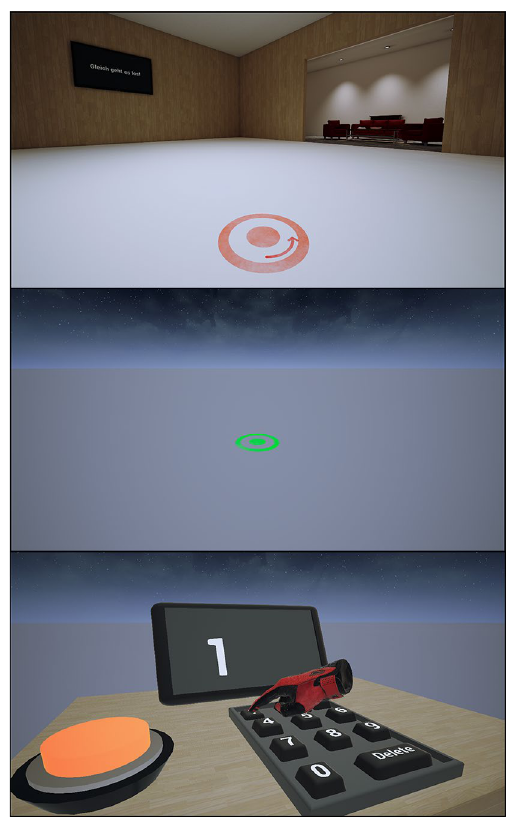
Figure 1. Screenshots of the virtual room environment (upper panel) and the ground plane environment (middle panel) that were custom created in Unreal Engine 4.25 for this research project and used in the experiments. Visual distance estimates were entered by the participants via a virtual numeric keyboard (lower panel).